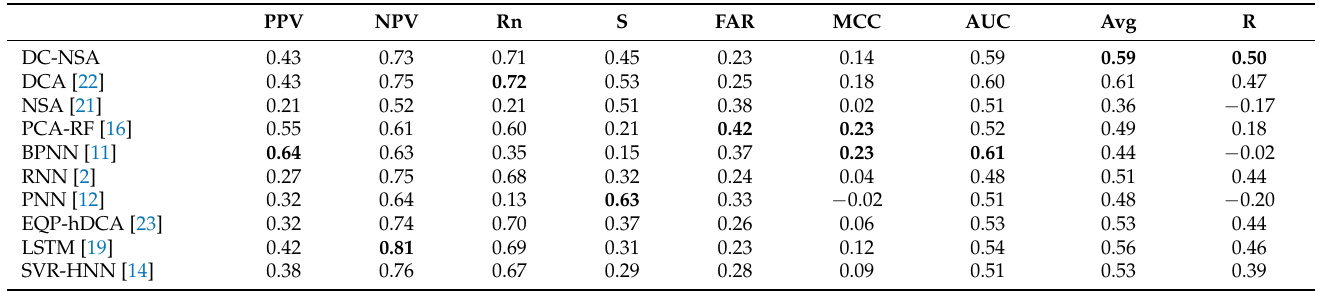
Table 5. Comparison between DC-NSA and other approaches when predicting DS1. The best results are in